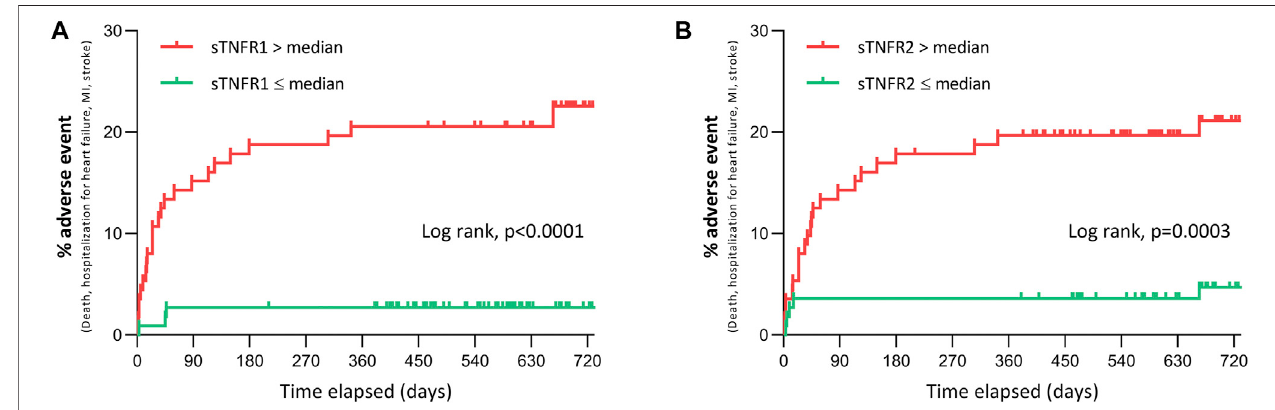
FIGURE 2 | Adverse clinical events at 24 months after STEMI according to 48 h sTNFR1 and sTNFR2. (A, B) Adverse clinical events (all-cause mortality, hospitalization for heart failure, myocardial infarction, or stroke) over 24 months after admission for suspected STEMI in patients with sTNFR1 (A) or sTNFR2 (B) concentration at 48 h either below or above the median value of the study population.